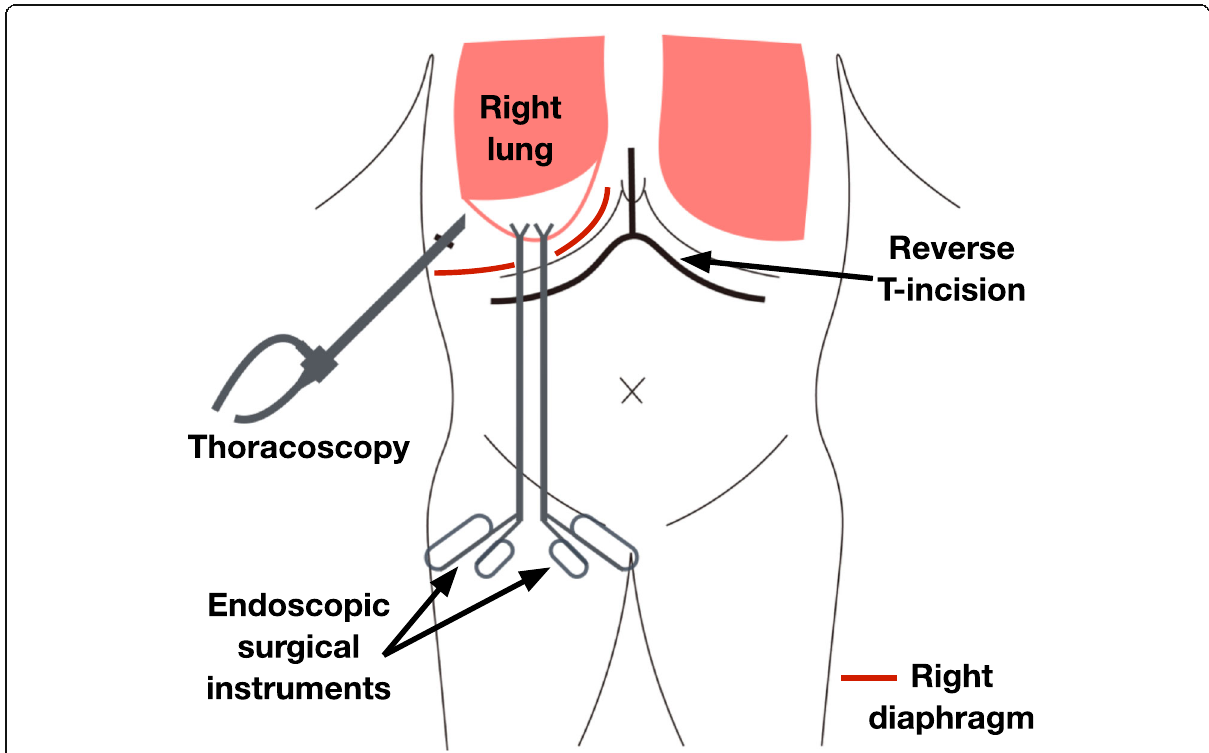
Fig. 2 Schematic illustration of a trans-diaphragmatic approach. A thoracoscope was inserted through the right tenth intercostal space, and endoscopic surgical instruments were inserted through the small incision of right